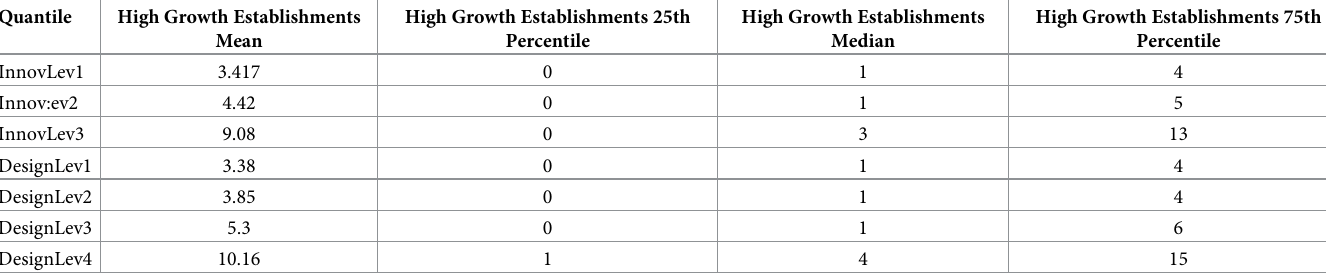
Table 6. Determining threshold values for ZIP codes using results from REIS